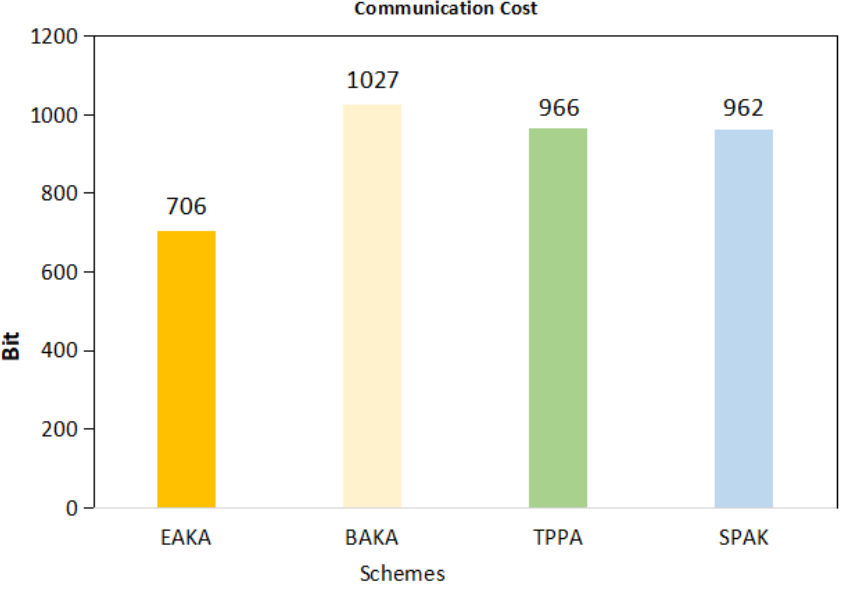
Figure 8. Communication cost of each scheme in authentication phase.